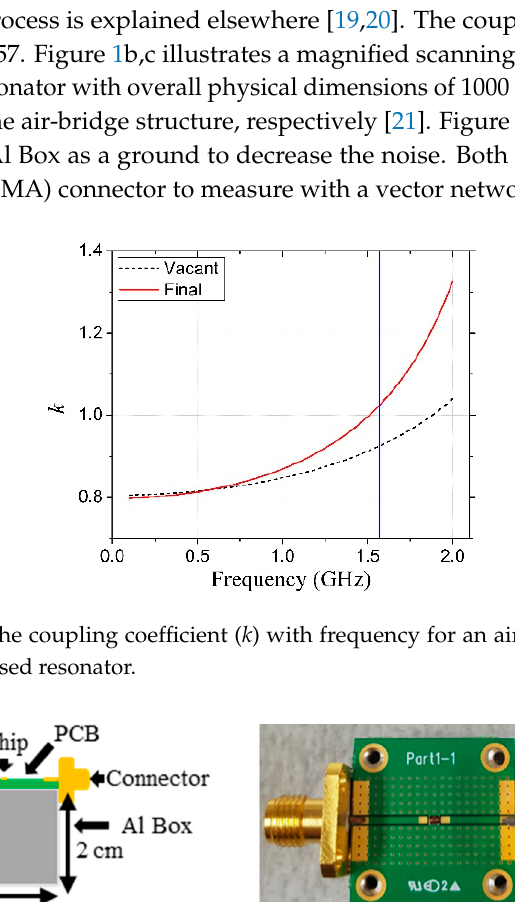
Figure 5. Simulated and measured S-parameters and the pictures of the fabricated resonator. Table 1, which compares our developed resonator with several recently reported IPD resonators, indicates that our work demonstrates a high-performance resonator with a more compact size and